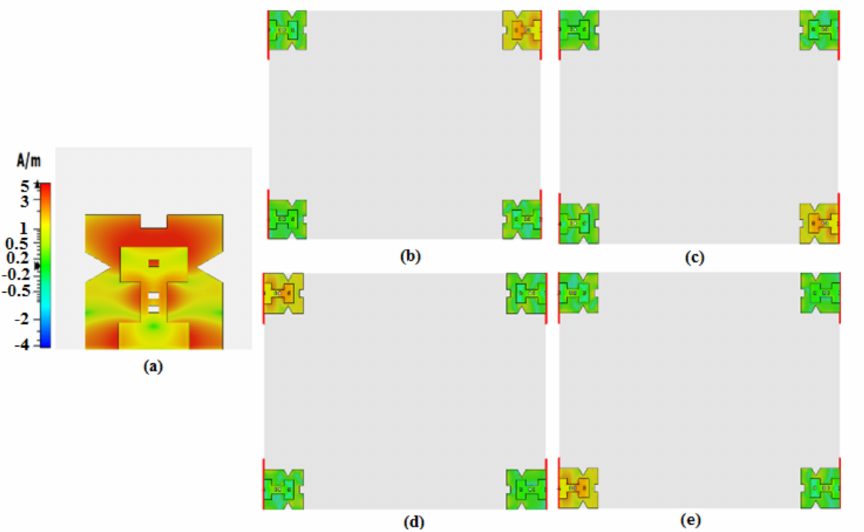
Figure 10. Surface current for the high-band MIMO final: ( a ) single element surface current distribu- tion; ( b ) MIMO-1 surface current distribution; ( c ) MIMO-2 surface current distribution; ( d ) MIMO-3 surface current distribution; ( e ) MIMO-4 surface current